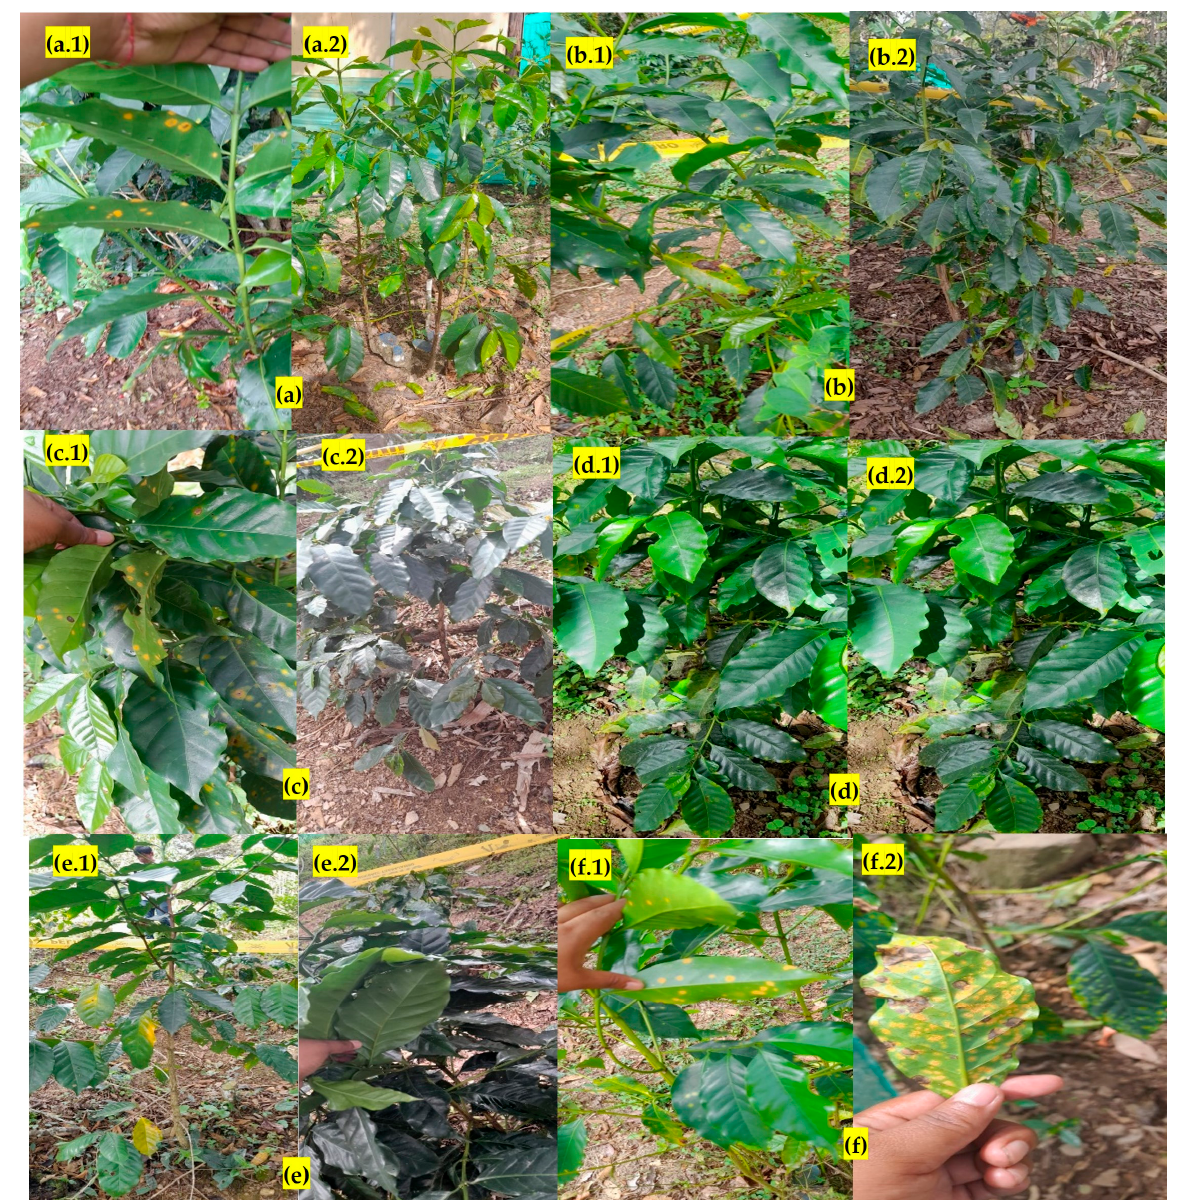
Figure 5. Biopesticide treatments before and after, ( a ) Oil ( b ) Infusion ( c ) Biol ( d ) Hydrolate ( e ) Macerated, ( f ) Control, ( a.1 , b.1 , c.1 , d.1 , e.1 , f.1 ) detail of the coffee plants without treatments, ( a.2 , b.2 , c.2 , d.2 , e.2 ) fourth week after applying the different treatments, the recovered coffee plants are observed, except in the control ( f2 ).